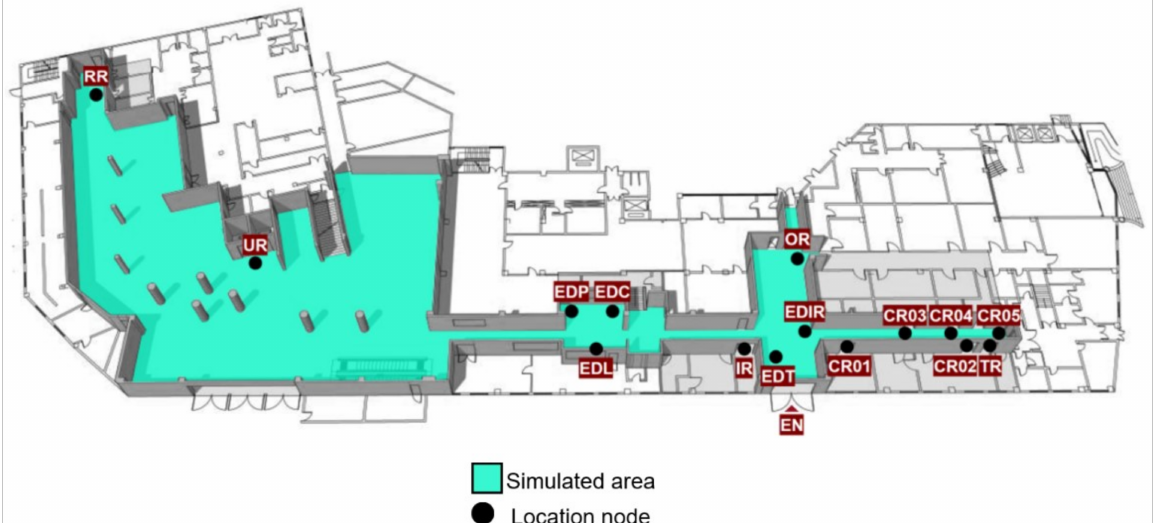
Figure 7. The 3D model of the Hospital A ED built environment.